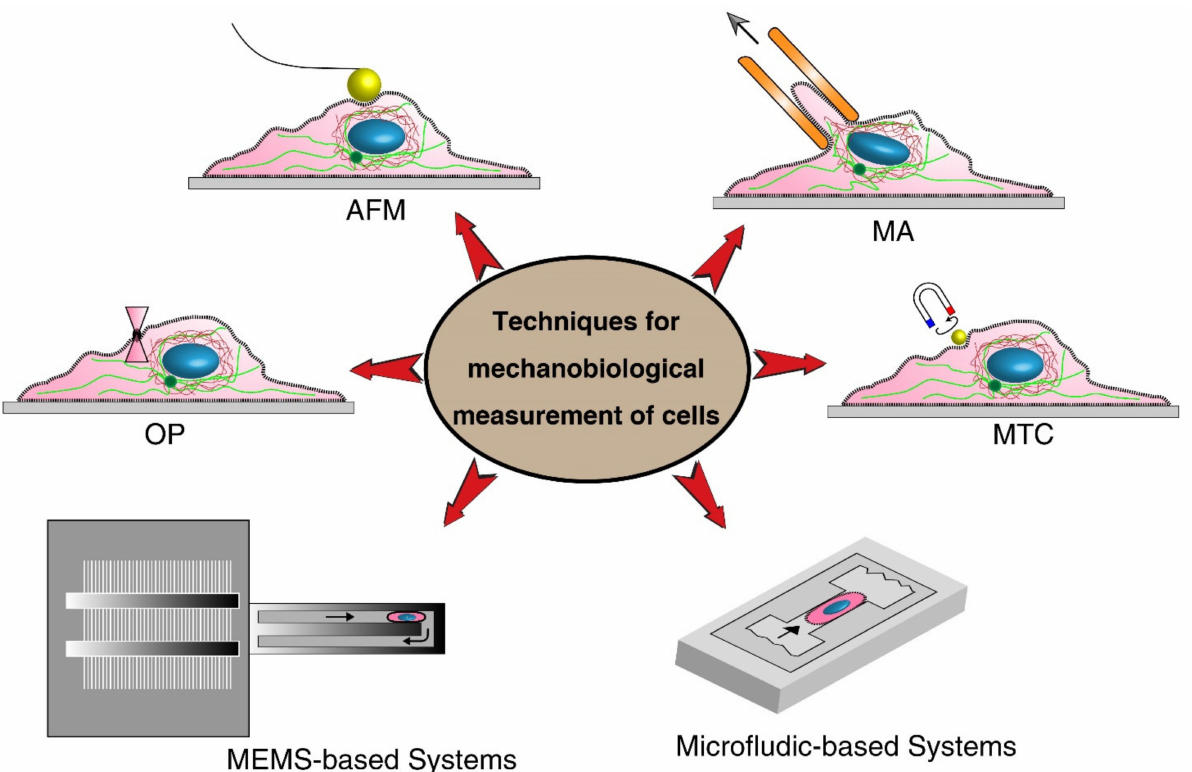
Figure 4. Different tools for the mechanical characterizations of living cells, Atomic Force Microscopy (AFM), optical tweezer (OP), micropipette aspiration (MA), magnetic twisting cytometry (MTC), MEMS, and microfluidic